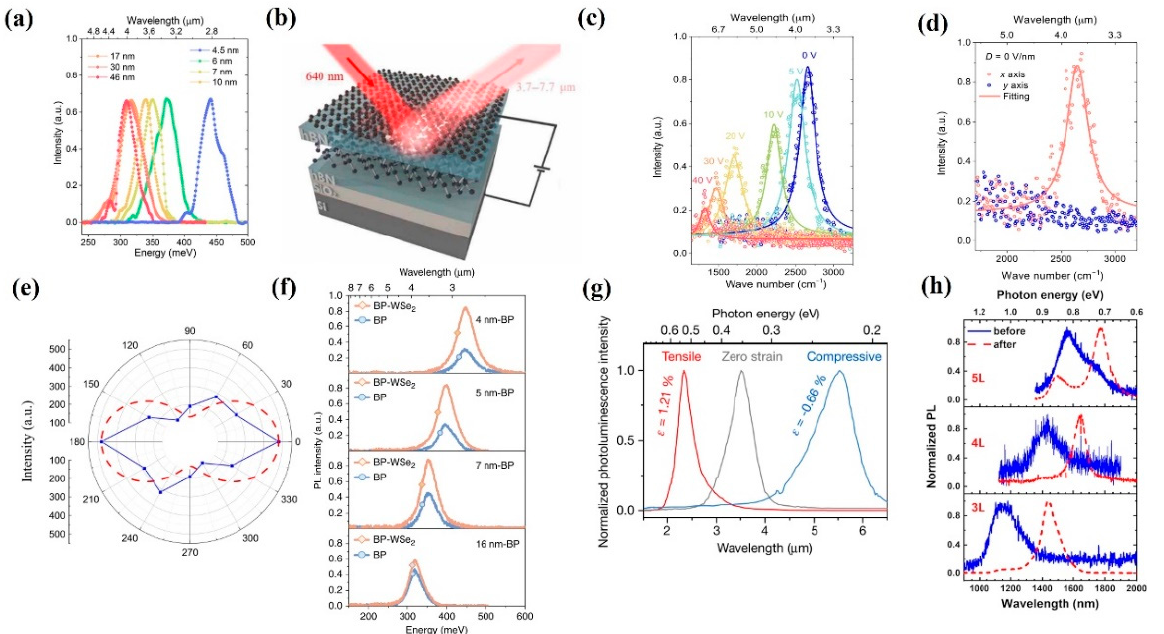
Figure 2. Light emission and devices based on BP. ( a ) The PL spectra as a function of various BP thicknesses. ( b , c ) The schematic and measured PL spectra of the device, respectively. ( d ) The PL spectra of BP under displacement fields of 0 V/nm. ( e ) The polarization − resolved EL spectra of the device. ( f ) The PL spectra of the device with various BP nanoflake thicknesses. ( g ) The PL intensity of BP with various applied strain. ( h ) The PL intensity of BP with and without annealing treatment.